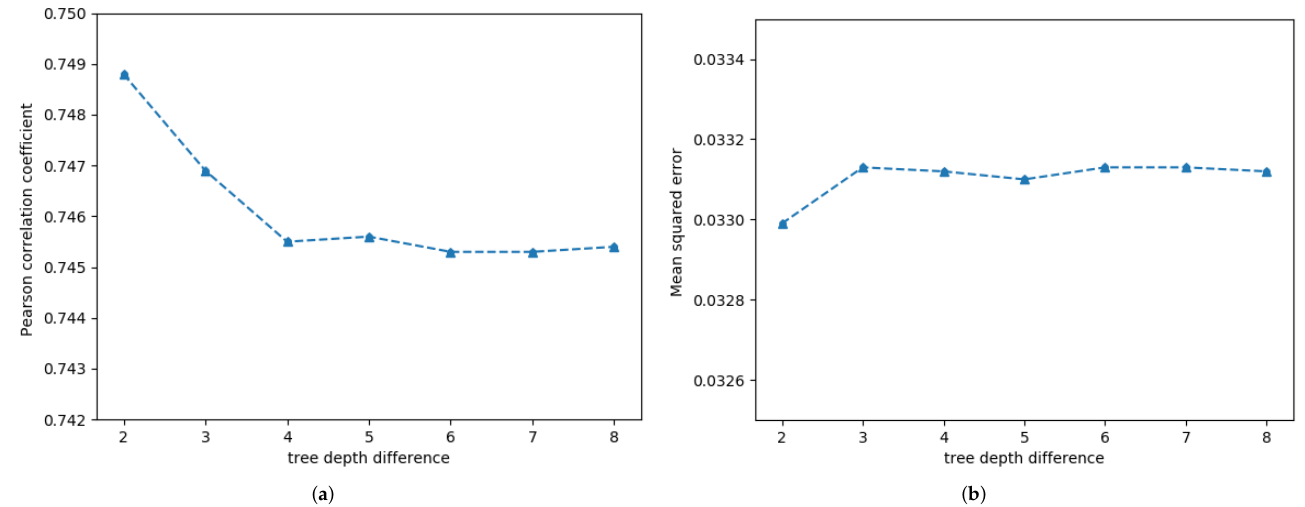
Figure 4. Detailed influence of the distance between the entangled words with indirect modified relationship on sentence semantics in STS’14.deft-news. ( a ) Pearson correlation coefficient, ( b ) Mean squred error.